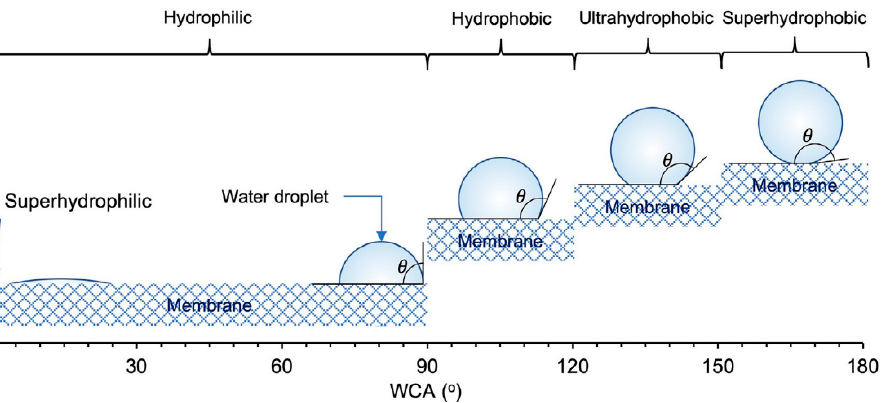
Figure 13. Membrane distillation (MD). ( A ) Desalination process in MD, ( B ) DCMD, ( C ) SGMD, ( D ) VMD, and ( E ) AGMD.